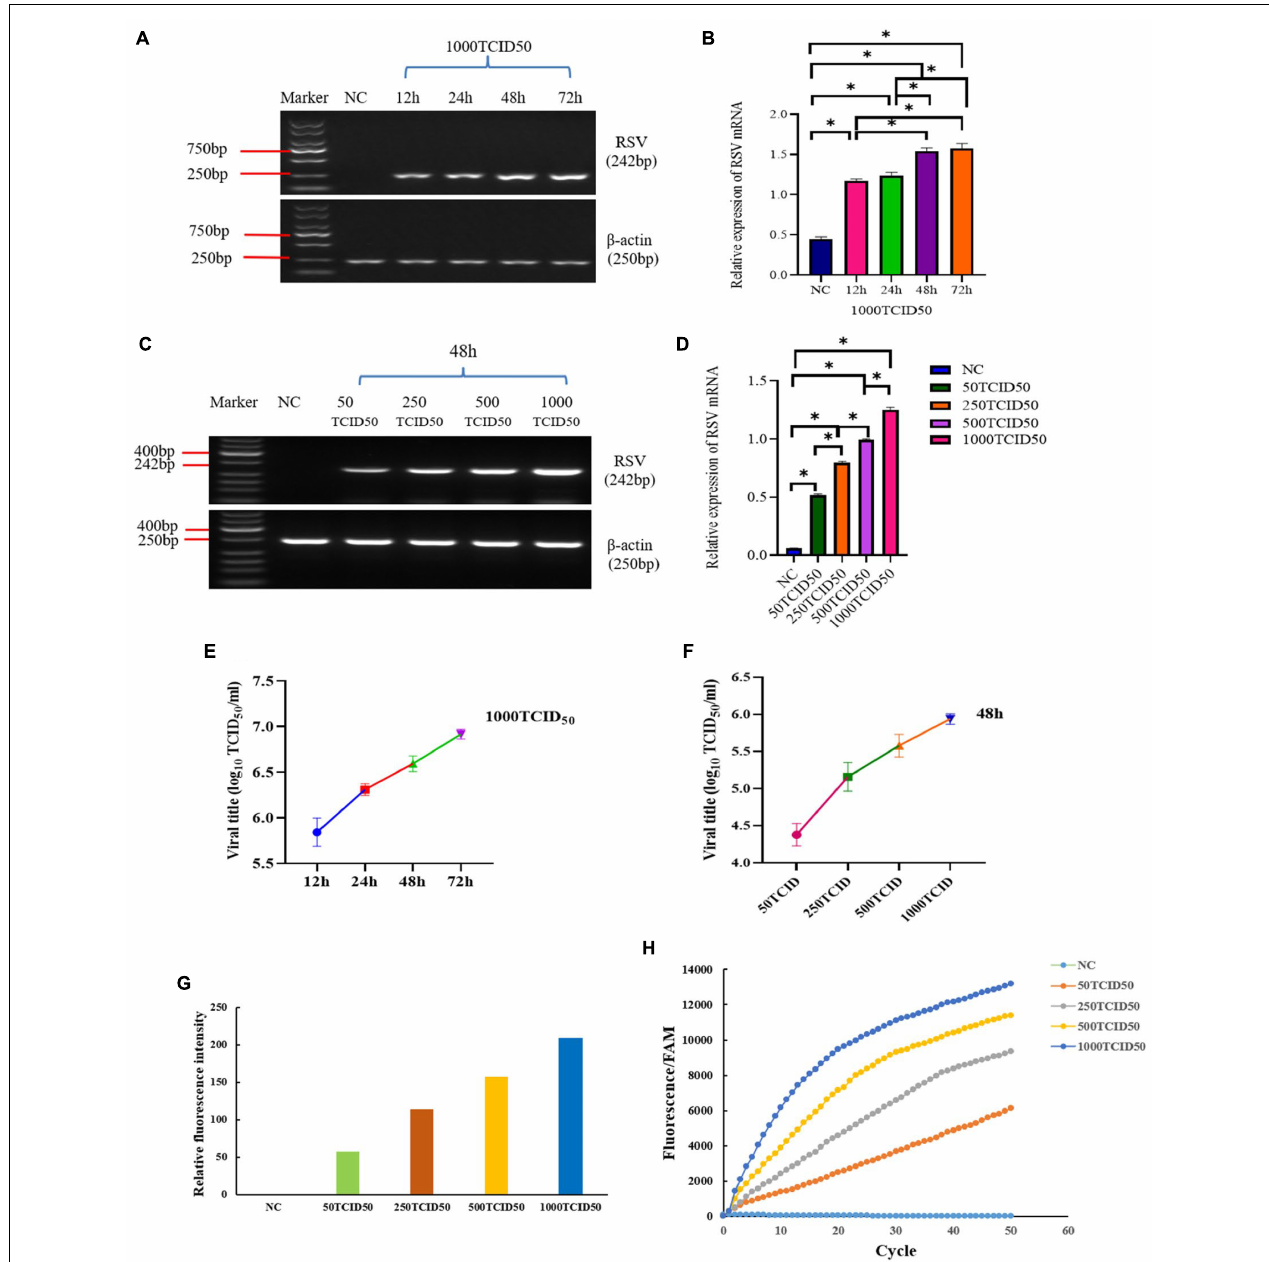
FIGURE 5 | The IT-RAISE system in RSV A-infected BEAS-2B cells. Cells were infected with 1000 TCID50 RSV A at 12h, 24h, 48h and 72h and detect RSV by PCR (A,B) . Cells were infected with 50TCID50, 250TCID50, 500TCID50, and 1000TCID50 RSV A at 48 h and detect RSV by PCR (C,D) , and afterward RSV titer (E) BEAS-2B cells were infected with 50TCID50, 250TCID50, 500TCID50, and 1,000TCID50 RSV A at 48 h, and afterward RSV titer (F) The IT-RAISE system detected fluorescence using a fluorescence multimode reader (G) and a real-time fluorescence PCR machine (H) when BEAS-2B cells were infected with 50TCID50, 250TCID50, 500TCID50, and 1,000TCID50 RSV A at 48 h. Detection of viral DNA using the IT-RAISE system. ∗ p < 0.05 indicates a statistically significant difference. All experiments were repeated three times ( n =